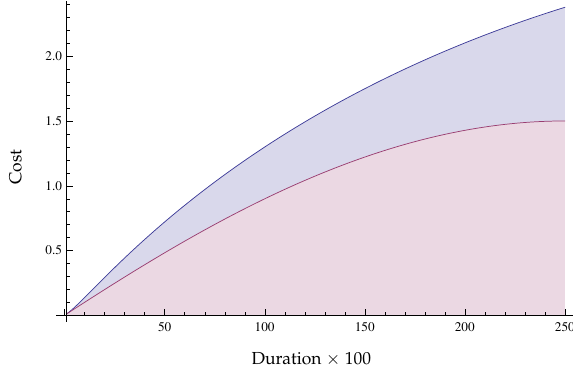
( 200, r ) (Violet) and Cost OFFLINE (Purple). ln